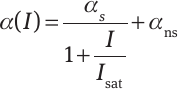
Figure 4: The optical characteristics of microfiber-VS (A) The linear transmittance of the microfiber-VS